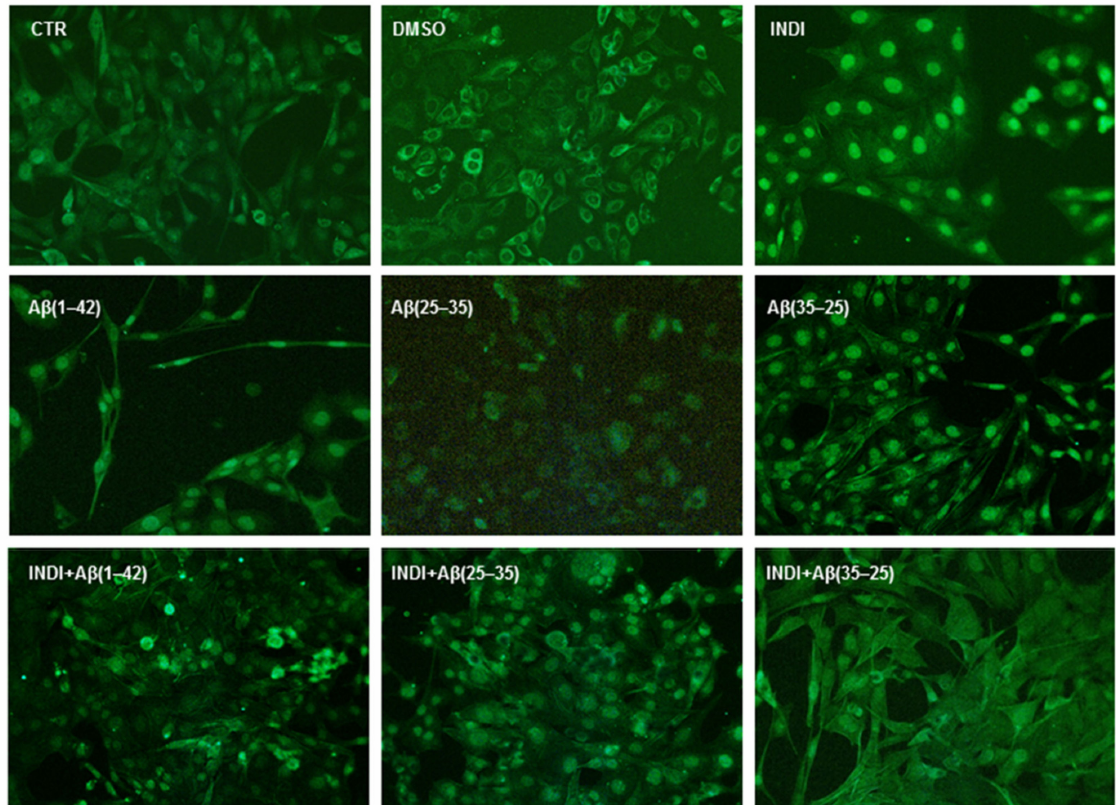
Figure 10. Immunocytochemistry for anti Nestin in OECs. Images show different conditions: control, DMSO, 100 µ M Indicaxanthin (INDI), 10 µ M A β (1-42) or A β (25-35) or A β (35-25) both in the absence and presence of 100 µ M INDI for 24 h. Scale bar 20 µ